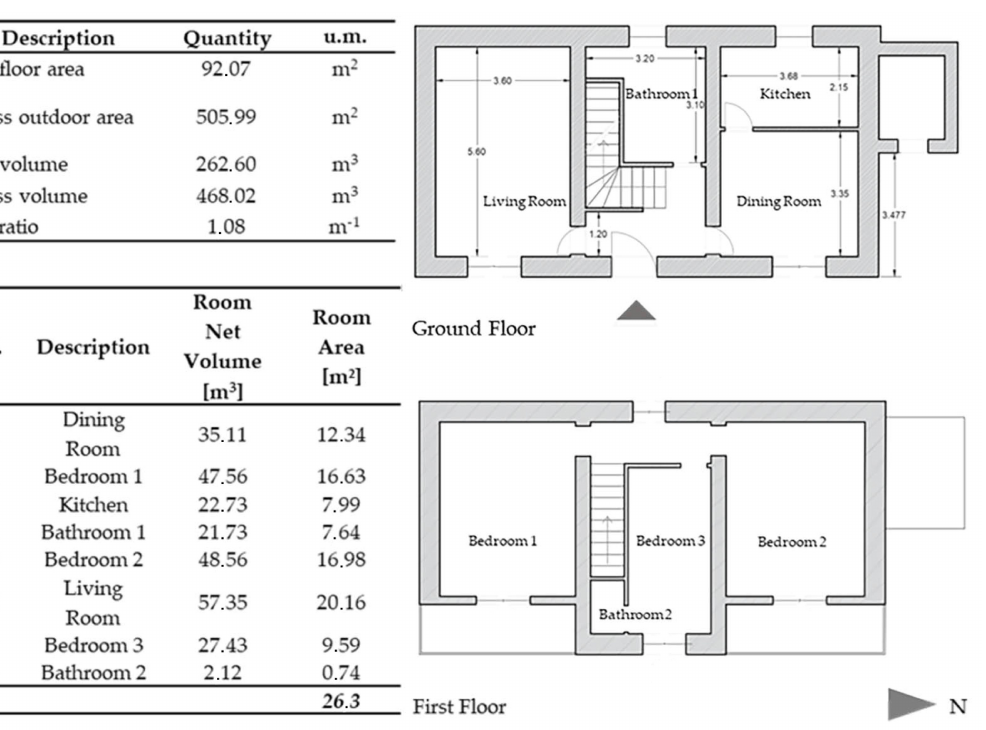
Figure 3. Demonstrator building